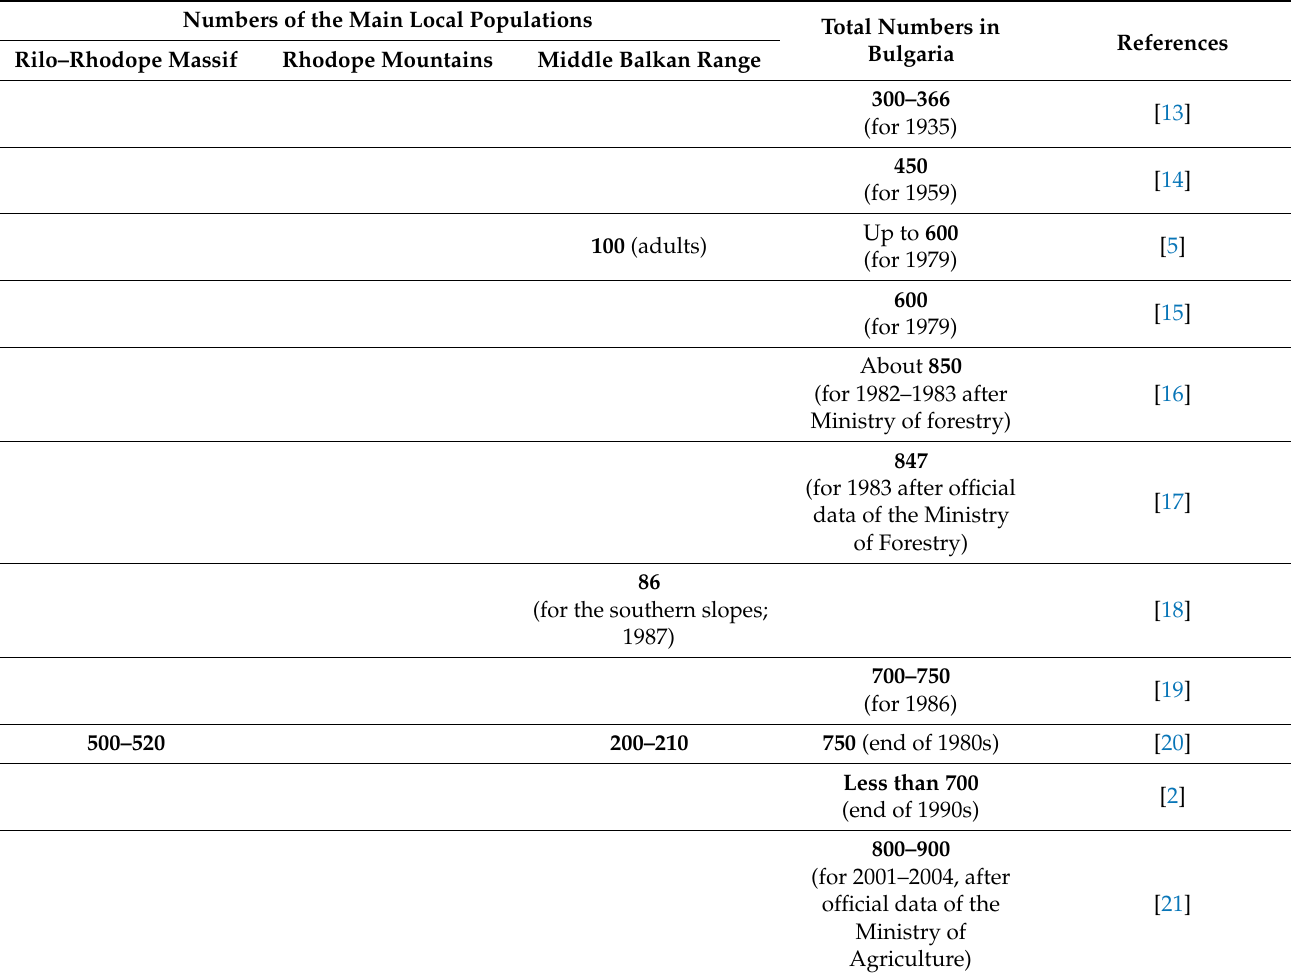
Table 1. Numbers of the Bulgarian bear population (for close to 100 years after different